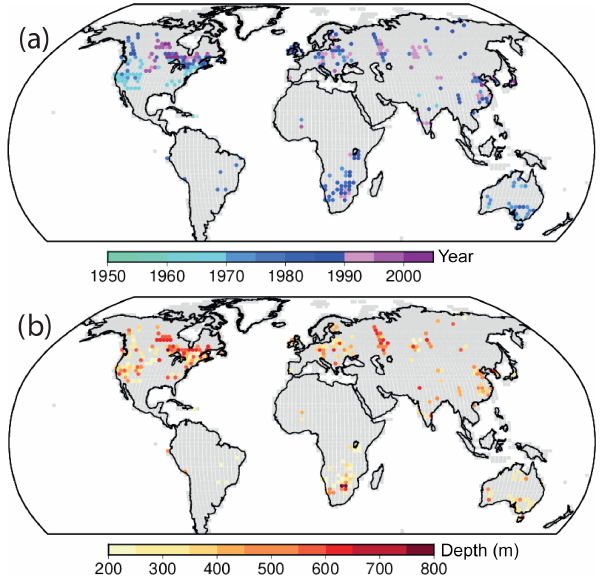
Figure 1. Spatial distribution of (a) the logging date and (b) the depths in the actual borehole